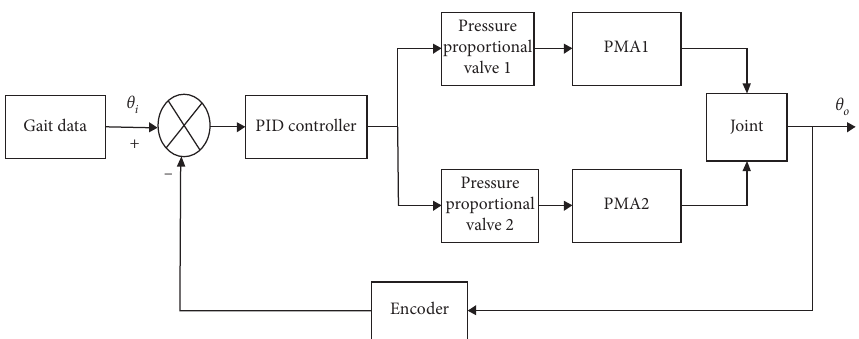
Figure 13: The process of knee joint driven by